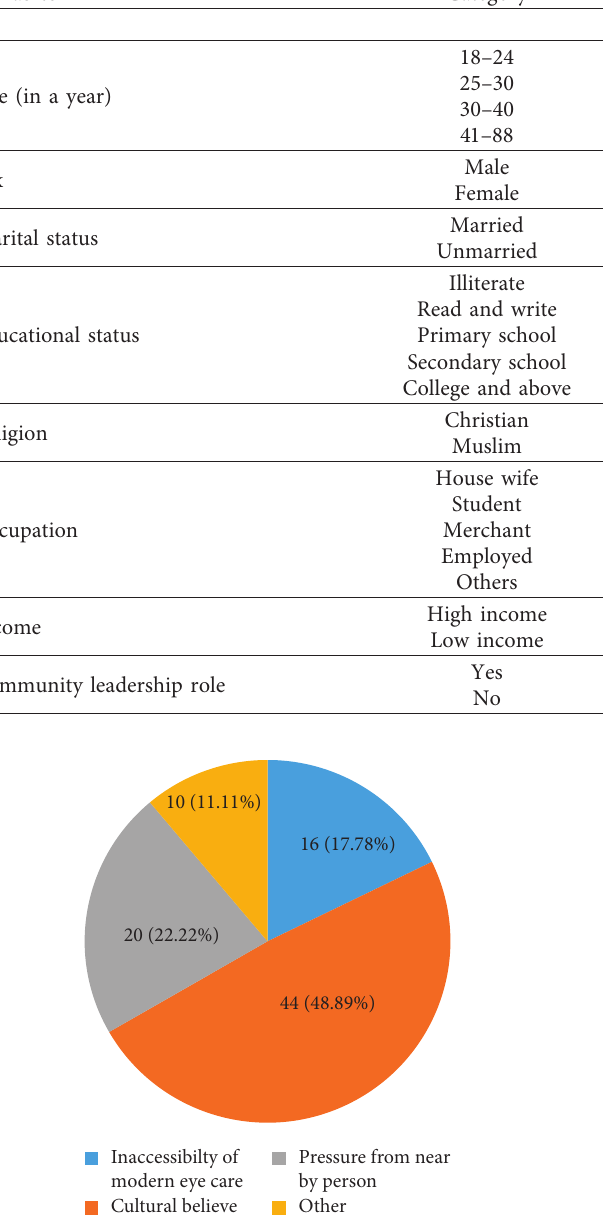
Table 2: Distribution of traditional eye medicine use in study participants among adult residents in Gondar city, North West Ethiopia, 2017. Variables